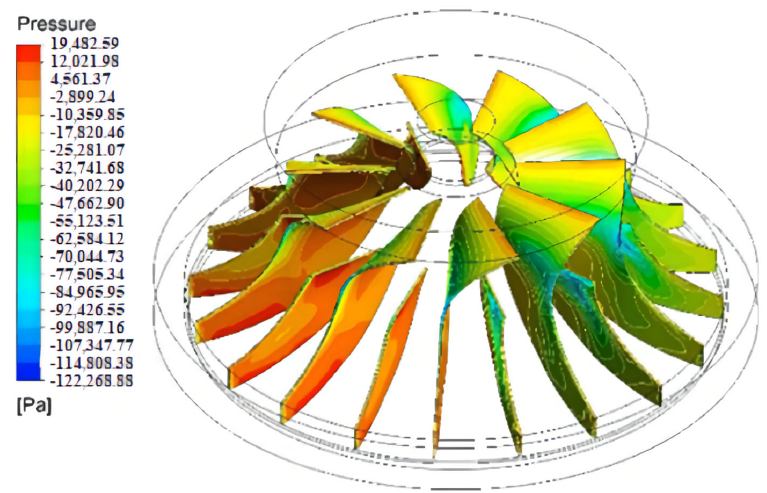
Figure 7. Pressure distribution of Type O.